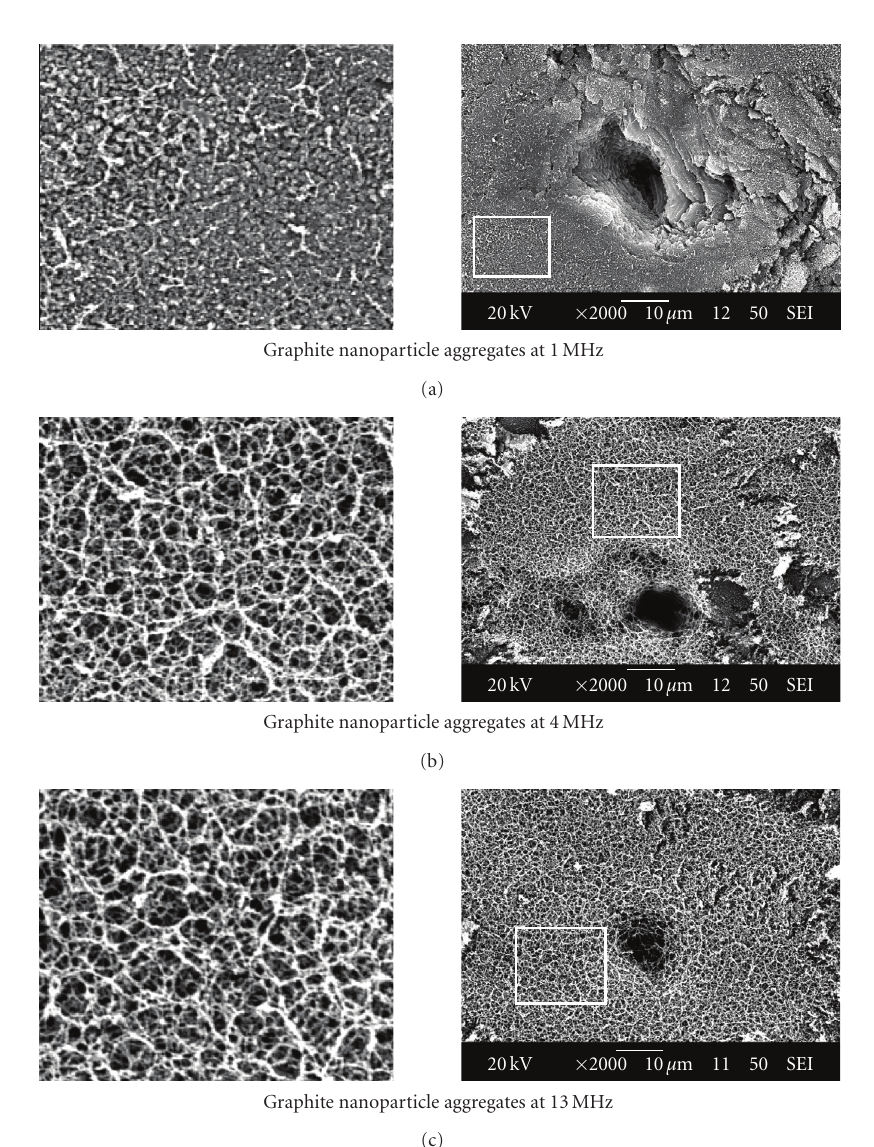
Figure 3: Graphite nanoparticle aggregate growth with laser pulse frequency.